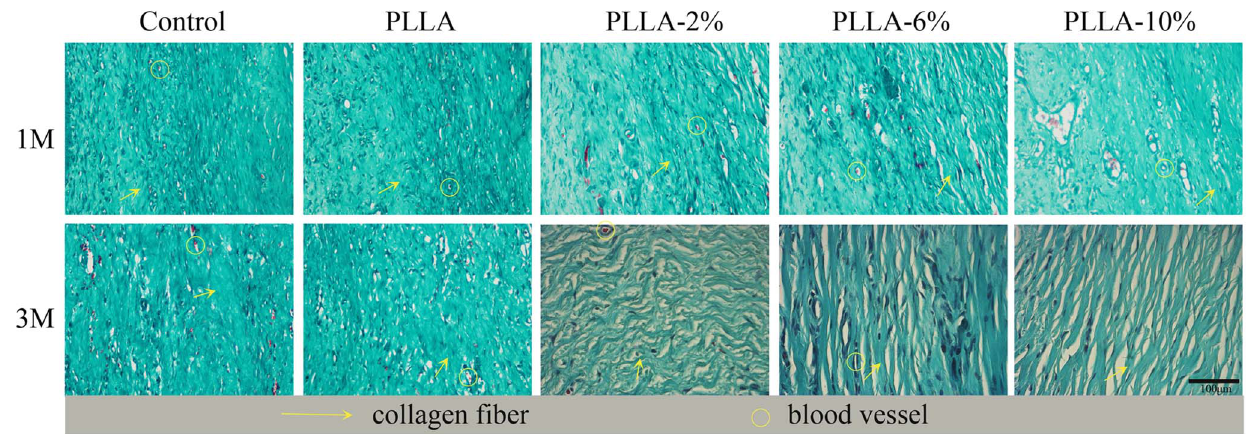
Figure 10. Masson’s staining of sections of scar hyperplasia at 1, and 3 months after wounding at 400 magnifications. The arrows represent the collagen fibers, and the circles represent the vessels. The bar represents for 100 m m.